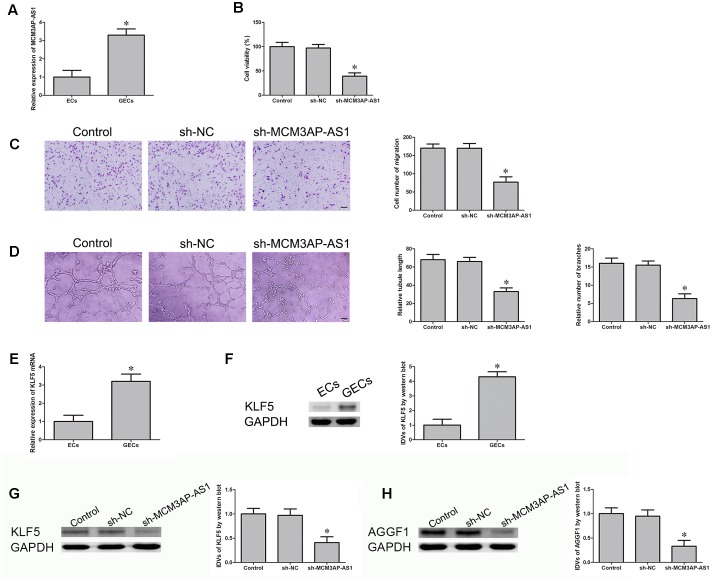
MCM3AP-AS1 expression in glioma-associated endothelial cells (GECs) and inhibition of MCM3AP-AS1 knockdown on glioblastoma (GBM) angiogenesis, KLF5, and AGGF1 expression. (A) Relative MCM3AP-AS1 expression in ECs and GECs by quantitative real-time PCR. Data are presented as mean ± SD. (n = 5, each group), ∗P < 0.01 vs. ECs group. (B) CCK-8 assay was used to evaluate the effect of MCM3AP-AS1 knockdown on GECs proliferation. (C) Effect of MCM3AP-AS1 knockdown on quantification number of GECs migration. (D) Effect of MCM3AP-AS1 knockdown on GECs tube formation. Data are presented as mean ± SD. (n = 5, each group), ∗P < 0.05 vs. sh-NC group. (E) Relative KLF5 mRNA expression in ECs and GECs by quantitative real-time PCR. (F) Relative KLF5 expression in ECs and GECs by Western blot assay. (G) The effect of MCM3AP-AS1 knockdown on expression of KLF5 by Western blot assay. (H) The effect of MCM3AP-AS1 knockdown on expression of AGGF1. Data are presented as mean ± SD. (n = 5, each group), ∗P < 0.01 vs. sh-NC group. Scale bars represent 30 μm.